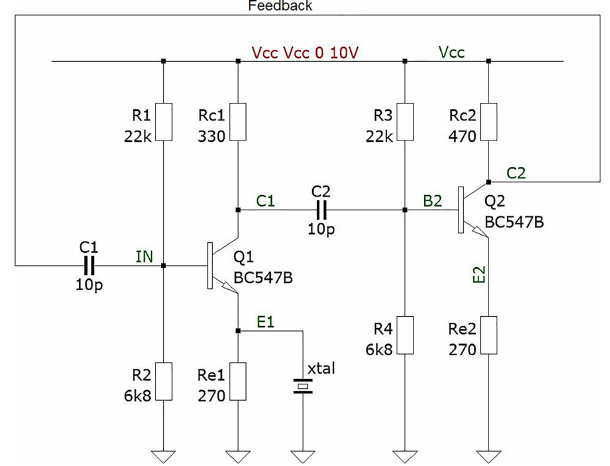
Figure 5. Functional principle of the oscillator circuit by Rösler (1997). This figure is the basis to explain the oscillator cir- cuit; the actual circuit is more sophisticated using an operational transconductance amplifier (OTA) instead of discrete